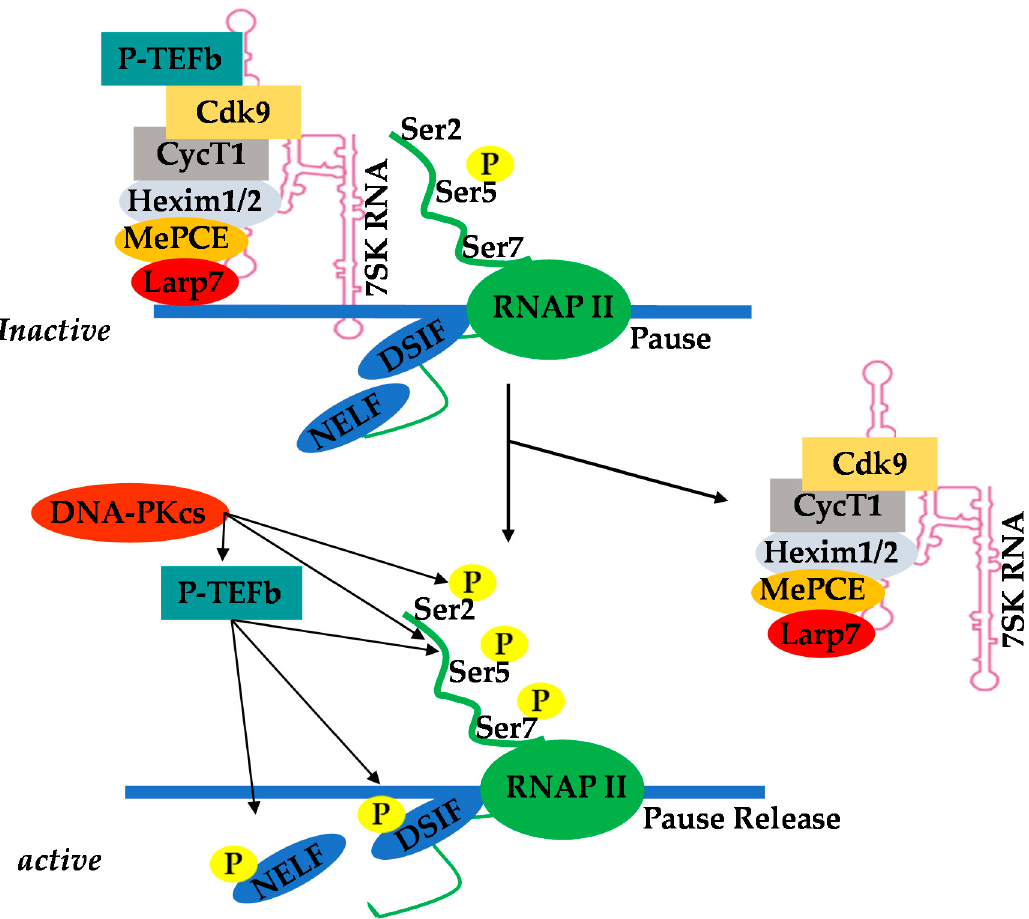
Figure 1. Equilibrium of positive transcription elongation factor b (P-TEFb) between the active pool and the inactive complex of 7SK small nuclear ribonucleoprotein (7SK snRNP).